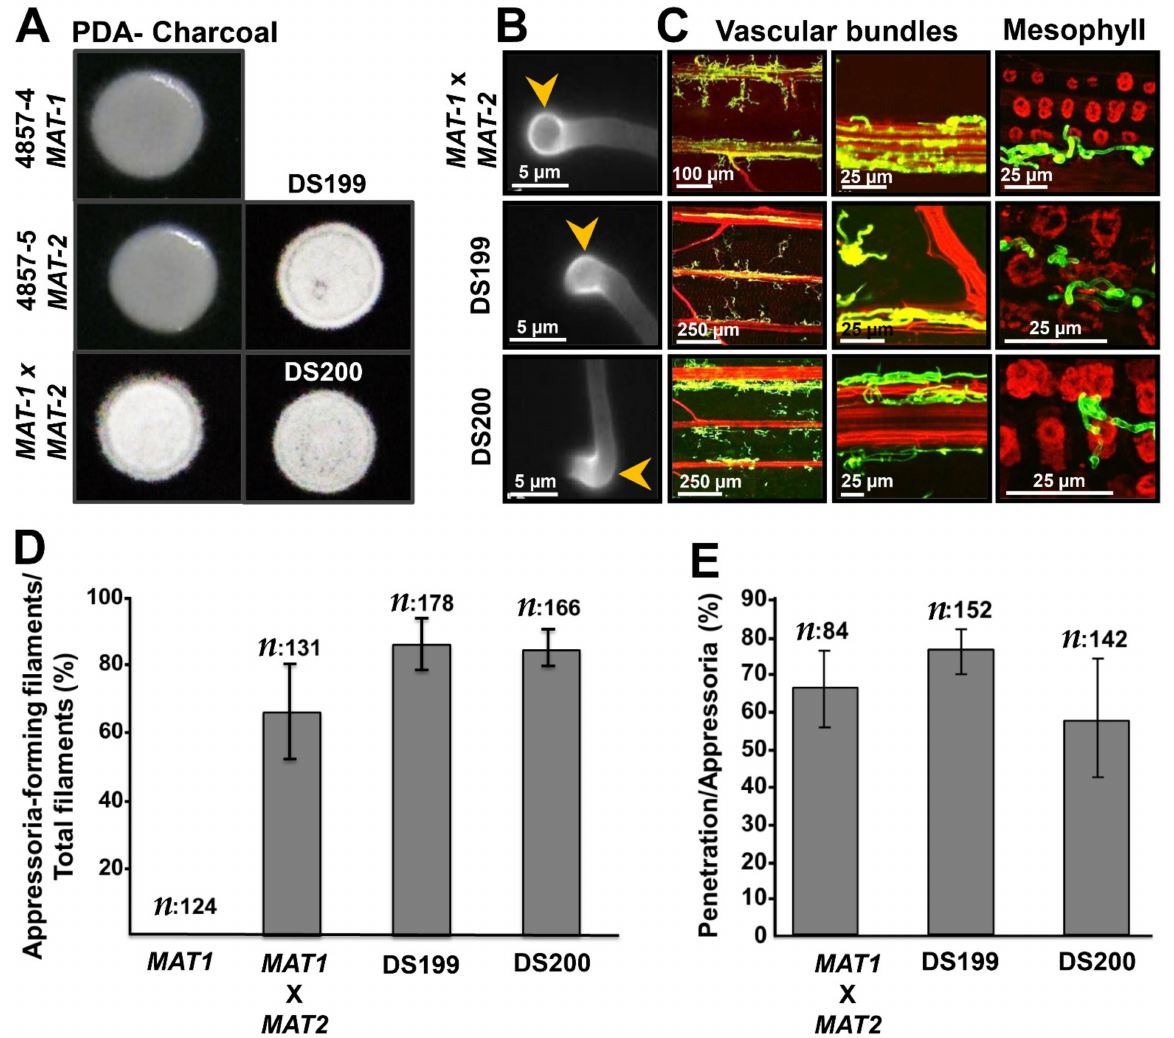
Figure 1. Generation of a solopathogenic Ustilago hordei strain. ( A ) Filamentation test on charcoal plate. U. hordei wild-type strains 4857-4 MAT-1 , 4857-5 MAT-2 , mating of 4857-4 MAT-1 × 4857-5 MAT-2 , solopathogenic DS199, and DS200 strains. Pictures were taken after 3 days incubation at RT. ( B ) Appressoria formation ability of U. hordei strains on parafilm. Mating of U. hordei wild-type 4857-4 MAT-1 and 4857-5 MAT-2 , solopathogenic DS199, solopathogenic DS200. Yellow arrowheads indicate appressoria. Pictures were taken after 24 h (hours) incubation ( C ) Disease development of different U. hordei strains on barley. Mating of U. hordei wild-type 4857-4 MAT-1 and 4857-5 MAT-2 at 3 dpi (days post inoculation), solopathogenic DS199 at 3 dpi, solopathogenic DS200 at 3 dpi. Following wheat germ agglutinin (WGA)-AF488/propidium iodide (PI) staining, fungal cell walls are shown in green and plant cell walls in red. ( D ) Quantification of appressoria formation for U. hordei wild-type 4857-4 MAT1 , solopathogenic DS199, and DS200 on plant. ( E ) Quantification of penetration efficiency for U. hordei wild-type 4857-4 MAT1 , solopathogenic DS199, and DS200 on